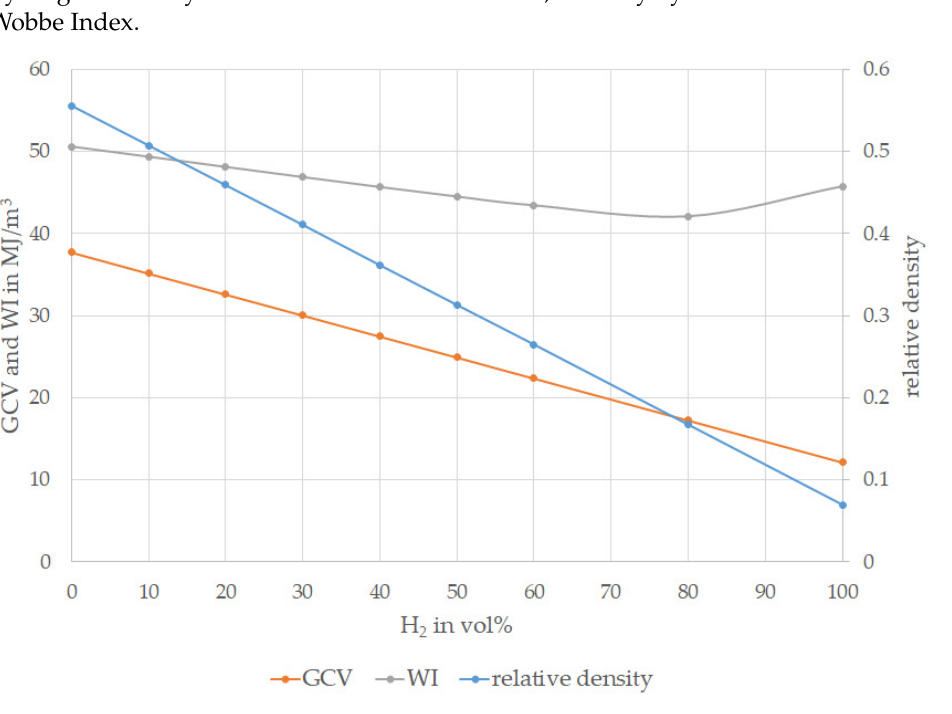
Figure 1. Relative densities, gross calorific values and Wobbe Indices for CH 4 /H 2 blends. All values given in the ISO reference system 15 °C/15 °C. So far, only a binary mixture of methane and hydrogen was considered. Natural gas, however, consists not only of methane, but also contains higher hydrocarbons (e.g., ethane and propane) or inert species such as carbon dioxide or nitrogen. Gas compositions vary depending on where the gas was extracted, how it was processed, and whether it was